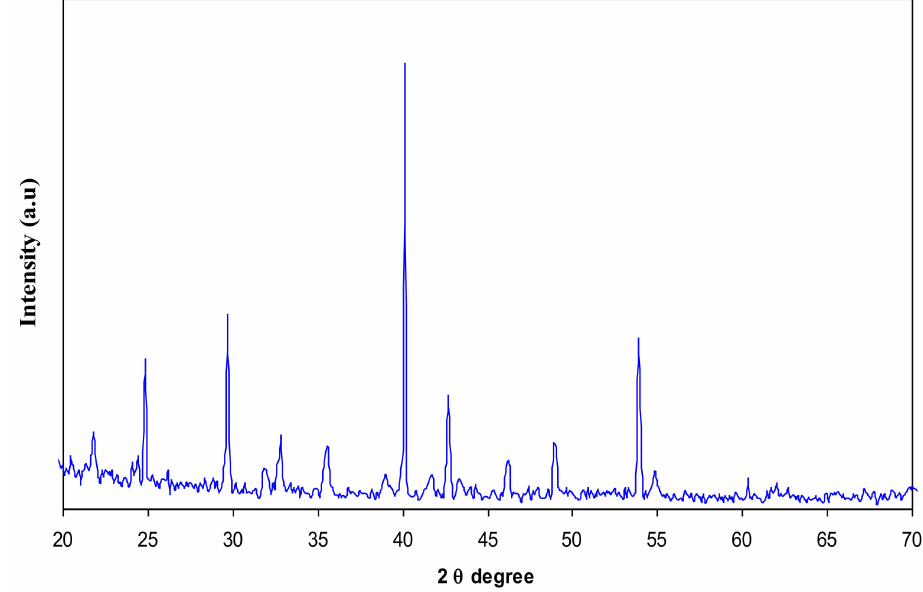
Figure 1. XRD pattern of pure silver nitrate